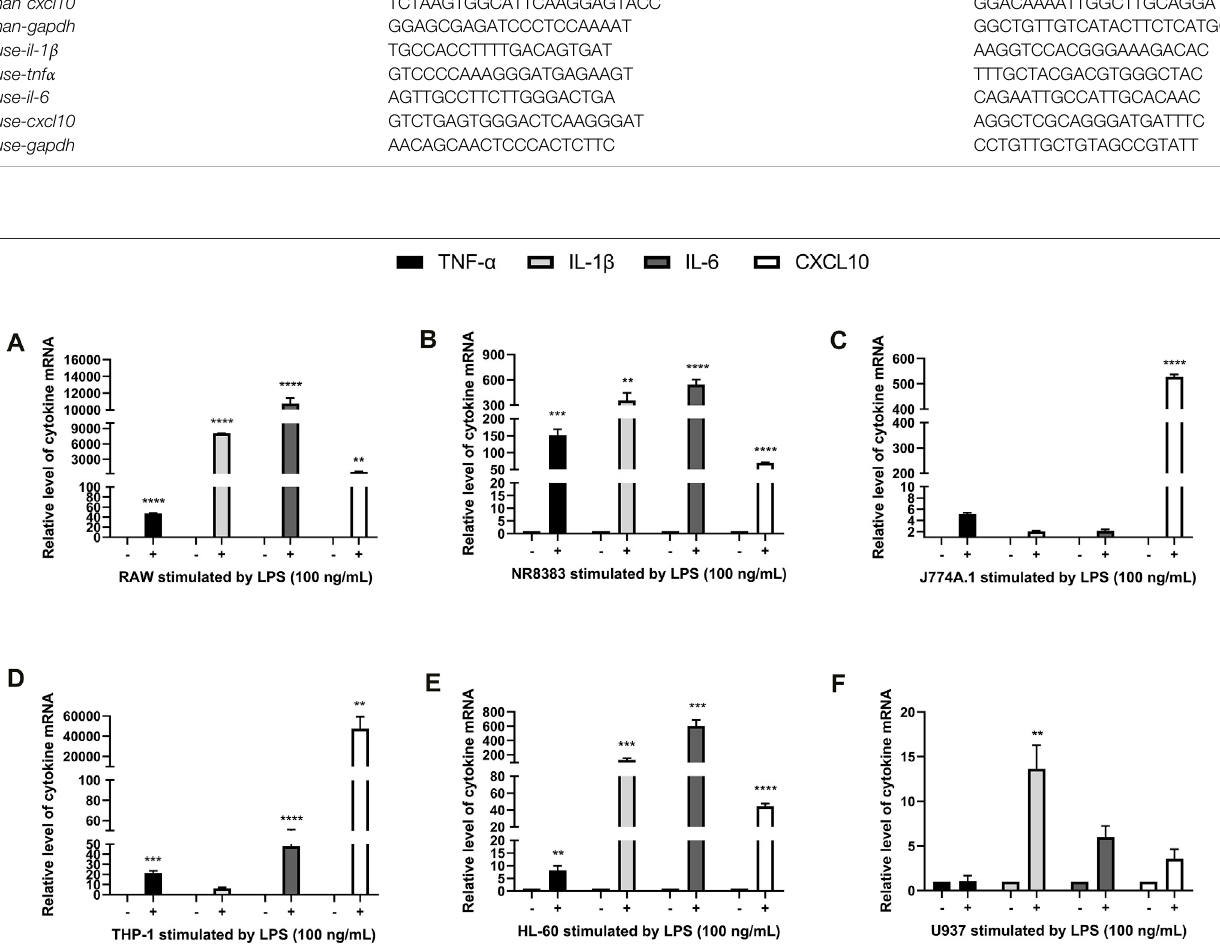
FIGURE1| LPSstimulatedcytokineexpression inmouse andhumanmacrophages. RT-PCR quanti fi cation ofTNF- α ,IL-6,IL-1 β ,and CXCL10 mRNAexpression in RAW (A) , NR8383 (B) , J774A.1 (C) , THP-1 (D) , HL-60 (E) and U937 (F) cells stimulated with LPS. (mean ± SD, n (cid:1) 3). ** p < 0.01, *** p < 0.001, **** p < 0.0001 vs. Control